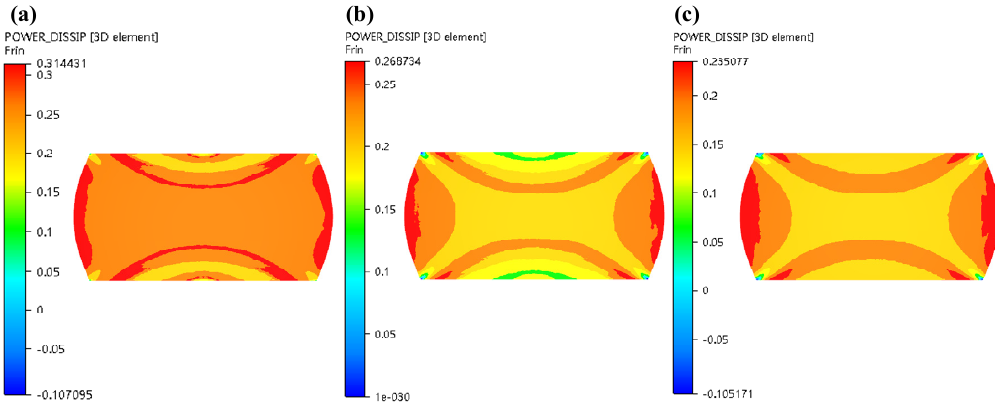
η Figure 16. Distributions of η (power dissipation coe ffi cient) in the condition of 1050 ◦ C / 0.7 (T = 1050 ◦ C, Figure 16. Distributions of (power dissipation coefficient) in the condition of 1050 °C/0.7 (T = 1050 ε = 0.7) under various strain rates: ( a ) . ε = 0.1 s − 1 ; ( b ) . ε = 0.5 s − 1 ; ( c ) . ε = 1 s − 1 ε  ε  ε  = 0.1 s − 1 ; ( b ) = 0.5 s − 1 ; ( c ) = 1 s − 1 . °C, ε = 0.7) under various strain rates: ( a )